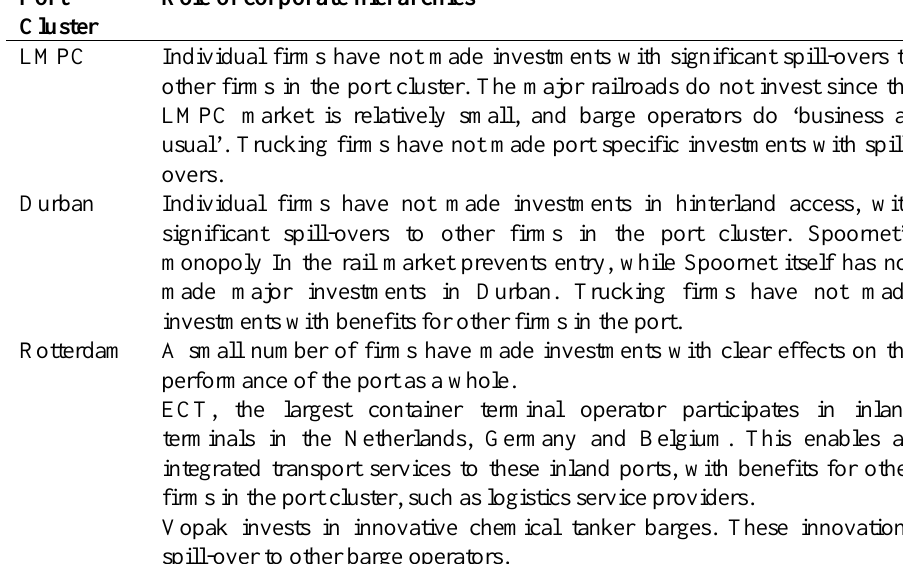
Table 8. The roles of hierarchies in the HAR of the LMPC, Durban and Rotterdam Port Role of corporate Cluster